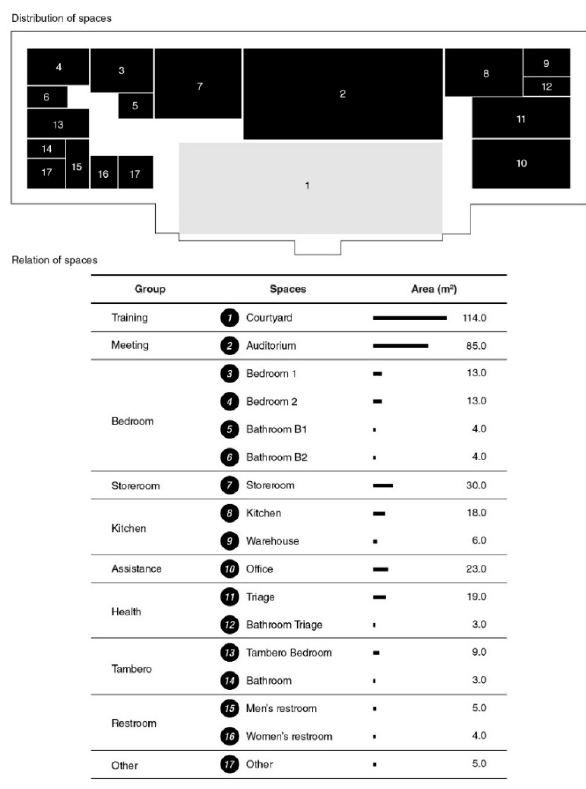
Figure 9. Distribution of spaces in a typical Tambo (source: